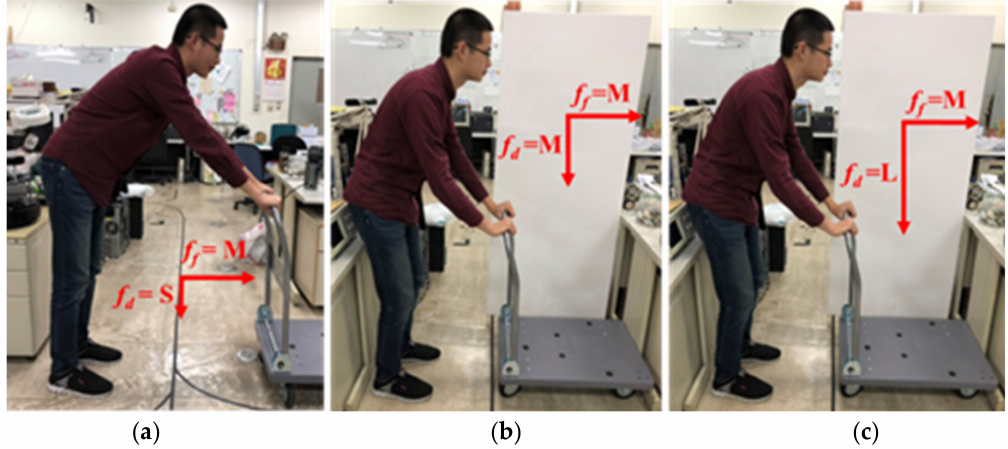
Figure 9. Posture judgment ( f f = M): ( a ) f d = S; ( b ) f d = M; ( c ) f d =